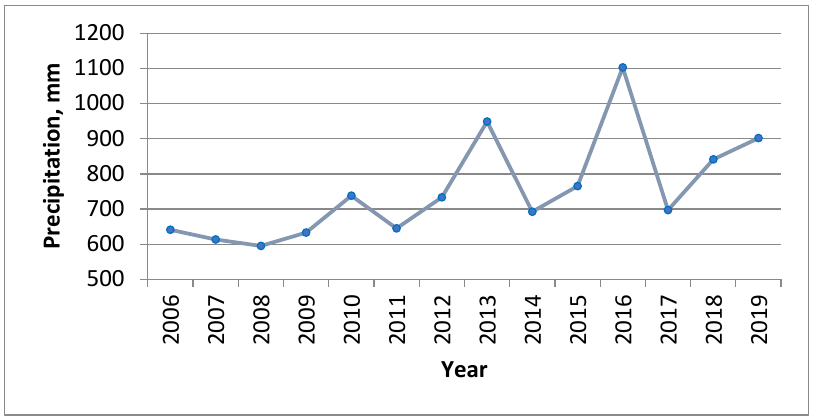
Figure 13. Fragments of DEM for the landslide area: ( a ) SRTM (black rectangle marks the borders of images from Figure 12); ( b ) World3D DEM; ( c ) TanDEM-X. Arrows mark the main scarp. The frame- work shows the location of the image fragments from Figure 12.